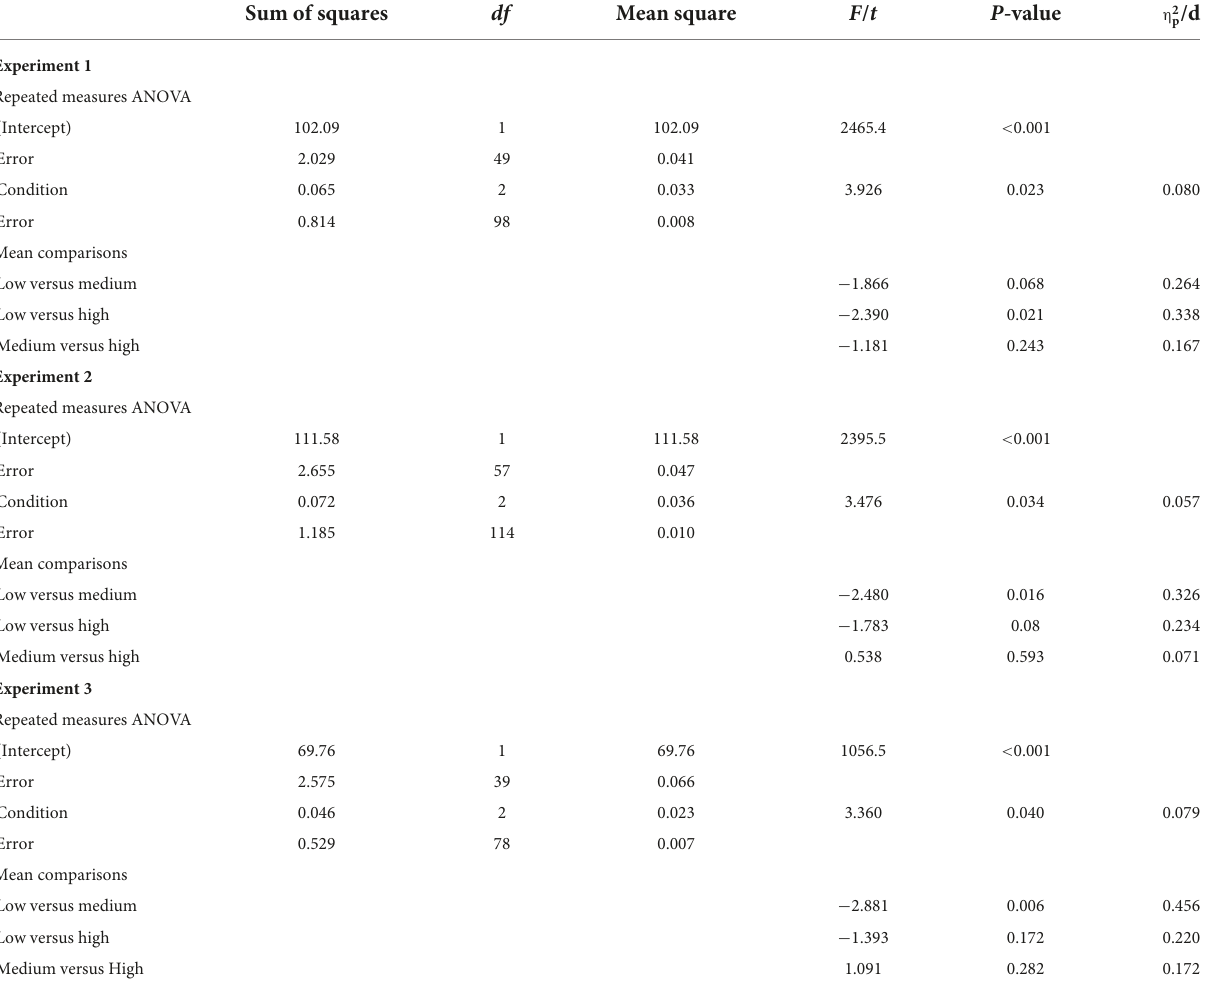
TABLE 2 Repeated measures ANOVAs for the average hit rate as a function of Condition (low, medium, and high reward probability) for each experiment separately. Sum of squares df Mean square F / t P -value η 2